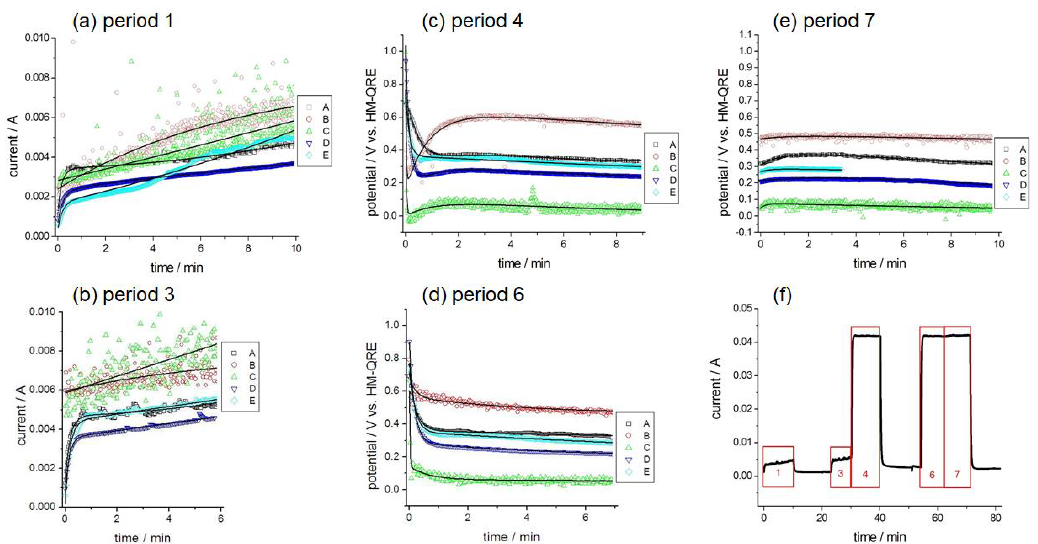
Figure 13. Electrochemical transients corresponding to the onset of abrasion or to the injection of